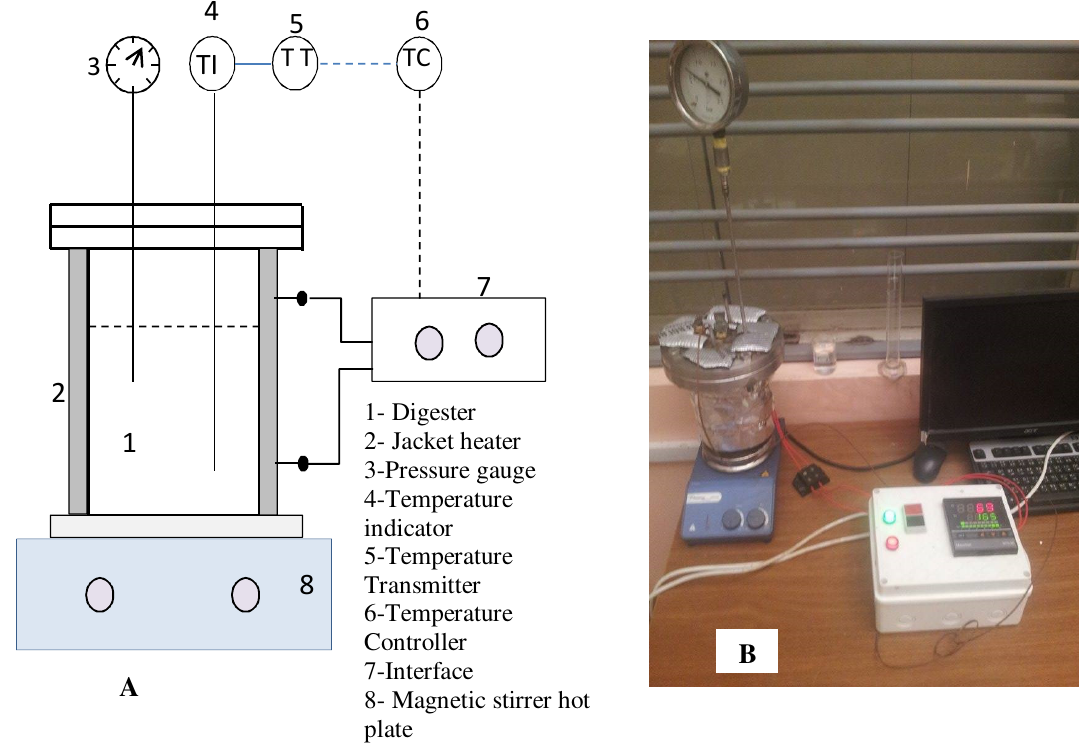
Fig. 1. A: Schematic Diagram of the reactor. B: The reactor and its components which used in